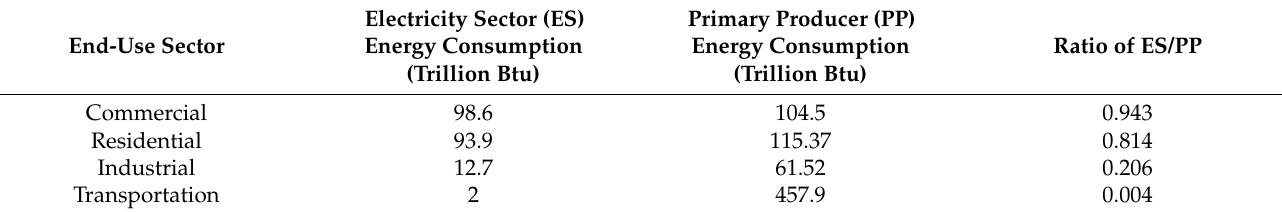
Table 2. End-use sectors’ consumption of electricity sector (ES) energy and primary producer (PP) energy for 2019. The ratio of electricity sector energy consumption to primary producer energy consumption (ES/PP) gives a measure of how closely a sector resembles a secondary consumer. Higher ratios indicate closer resemblance of a secondary consumer. The PP’s consume energy from natural resources and the ES consume